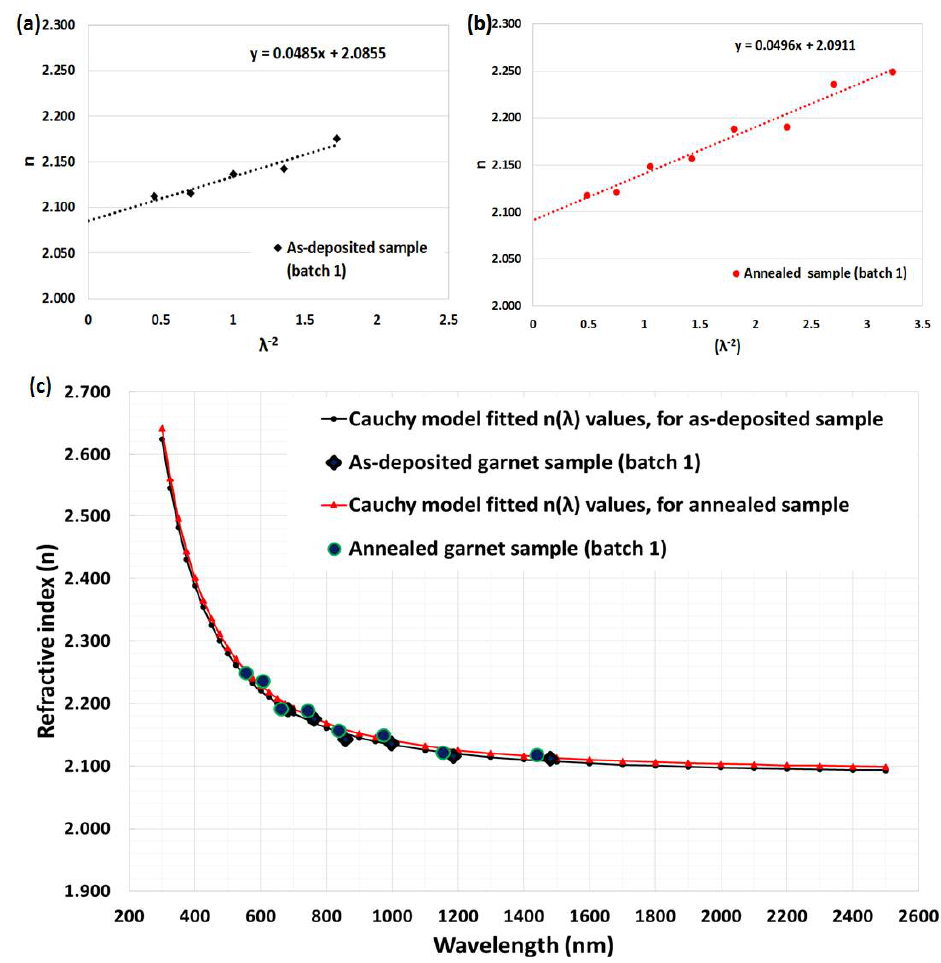
Figure 7. Least square fit of calculated refractive index (n 2 ) values for garnet samples (batch-1); ( a ) as-deposited and ( b ) annealed. ( c ) Calculated refractive index spectra using Cauchy’s model and measured transmission spectra, for as-deposited and annealed samples.